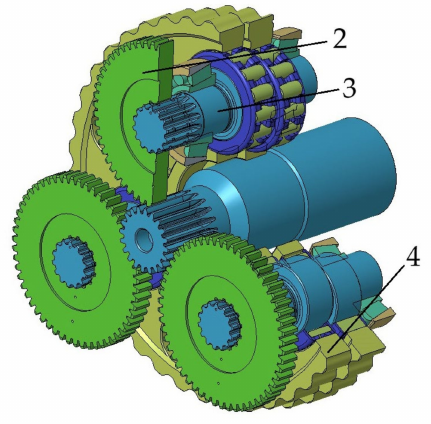
Figure 2. Model of local needle roller bearing.